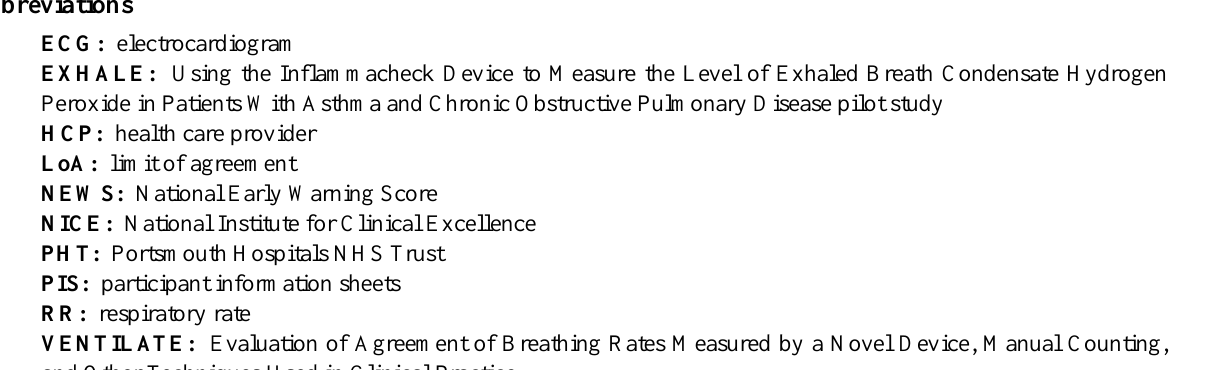
Abbreviations ECG: